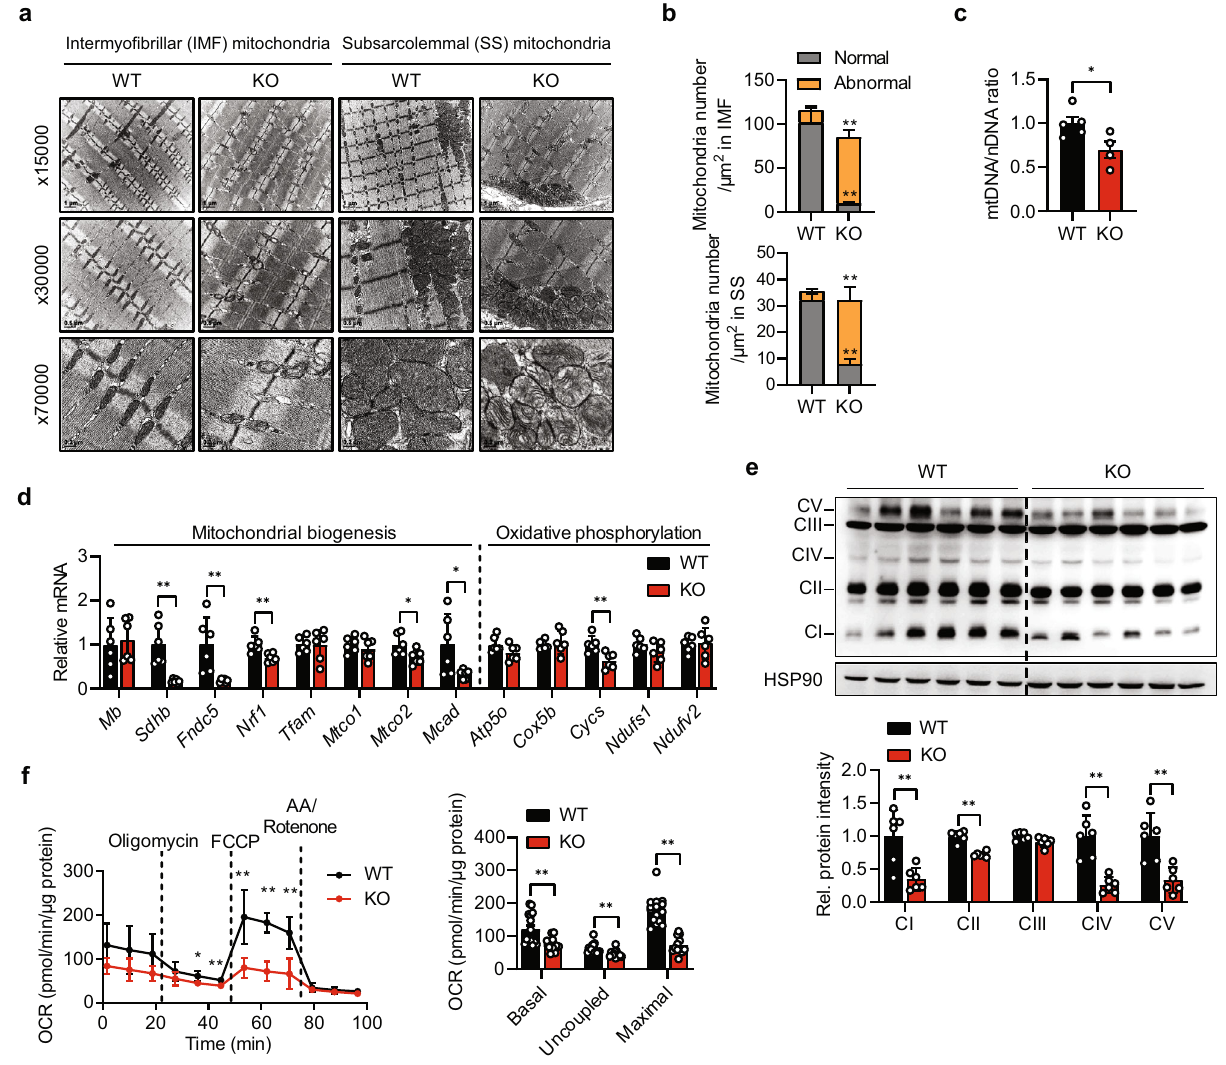
Fig. 3 Decrease in oxidative capacity in Sirt6 KO mice at basal condition. a Representative transmission electron micrograph of gastrocnemius muscles (GAS) from WT and Sirt6 KO mice. b Numbers of mitochondria with normal or abnormal morphology were counted from images in ( a ) ( n = 4). c Mitochondrial DNA (mtDNA) was quanti fi ed by qPCR using nuclear DNA (nDNA) as a standard ( n = 5 for WT, n = 4 KO). d qPCR analysis of genes related to mitochondrial biogenesis and oxidative phosphorylation (OxPhos) in GAS ( n = 6). Expression of each gene was normalized with housekeeping Gapdh whereas expression of mitochondrial genome-encoded genes Mtco1 and Mtco2 was normalized with 16S rRNA . e Representative Western blot analysis of OxPhos complex ( n = 6). f Oxygen consumption rate (OCR) was measured using Seahorse XF analyzer in myo fi bers isolated from GAS. Basal respiration, respiration related to ATP production (uncoupled, difference between OCR before and after oligomycin injection), and maximal respiration (difference between OCR after FCCP and antimycin A (AA)/rotenone injection) were determined ( n = 15 for WT, n = 12 for KO). Values are mean ± SEM. Data are representative of at least three independent experiments. Unpaired two-tailed t test between two groups was conducted for statistical analyses ( b – f ). * p < 0.05 and ** p < 0.01. Source data are provided as a Source Data fi